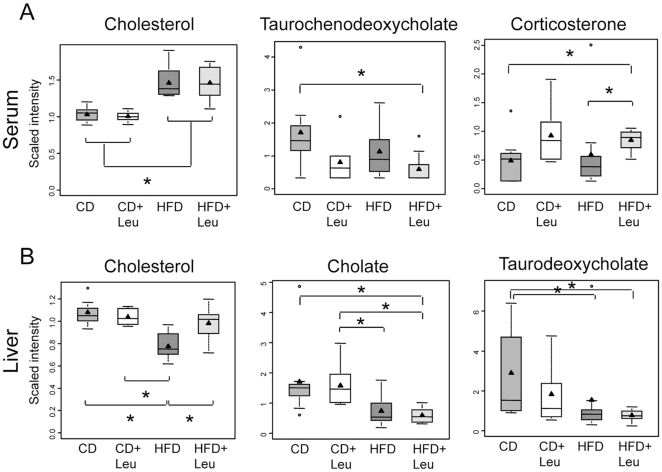
Changes in cholesterol, bile acids and sterol metabolism in serum and liver.After 8 weeks on each diet, serum and liver were obtained, extracted and subjected to non-targeted metabolomic analysis by UHPLC-MS/MS and GC-MS (Metabolon). Box-and-whisker plots showing relative levels of A) serum sterol, bile acid, and steroid levels, and B) liver cholesterol and bile acid metabolites in sterol-bile acid biosynthetic pathway. 3–9 samples per group were used. *P<0.05.